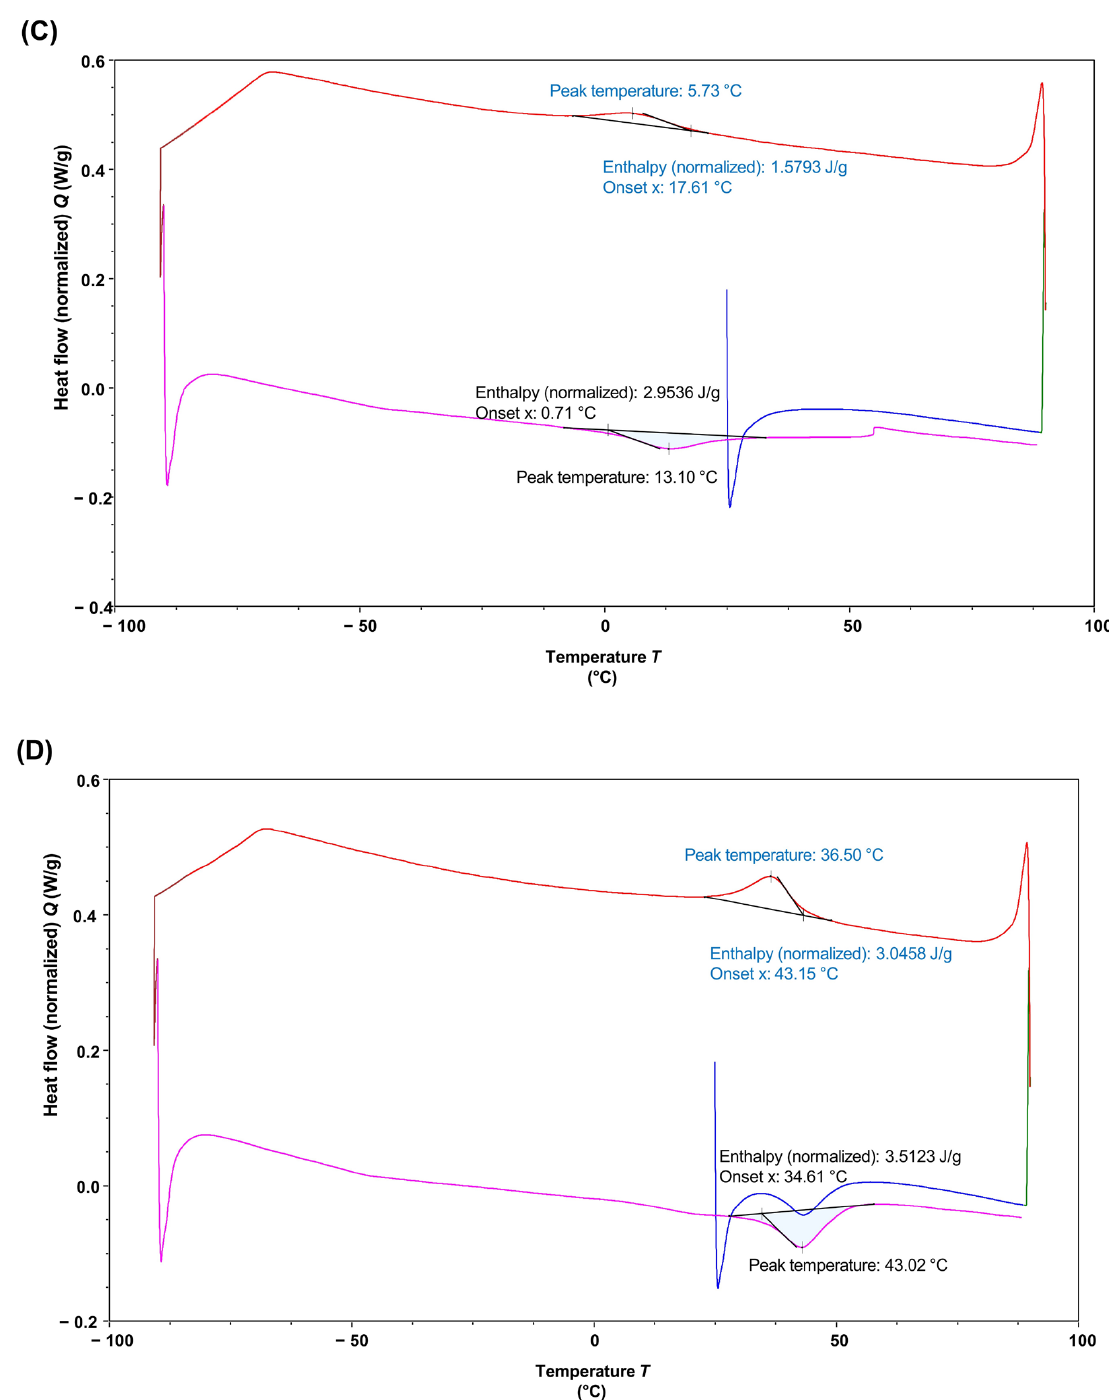
Figure 5. Differential scanning calorimetry curves for TruNatomy Prime ( A ), XP-endo Shaper ( B ), Spring Endo ( C ), and Spring H files ( D ). The upper and lower curves represent the cooling and heating curves, respectively.